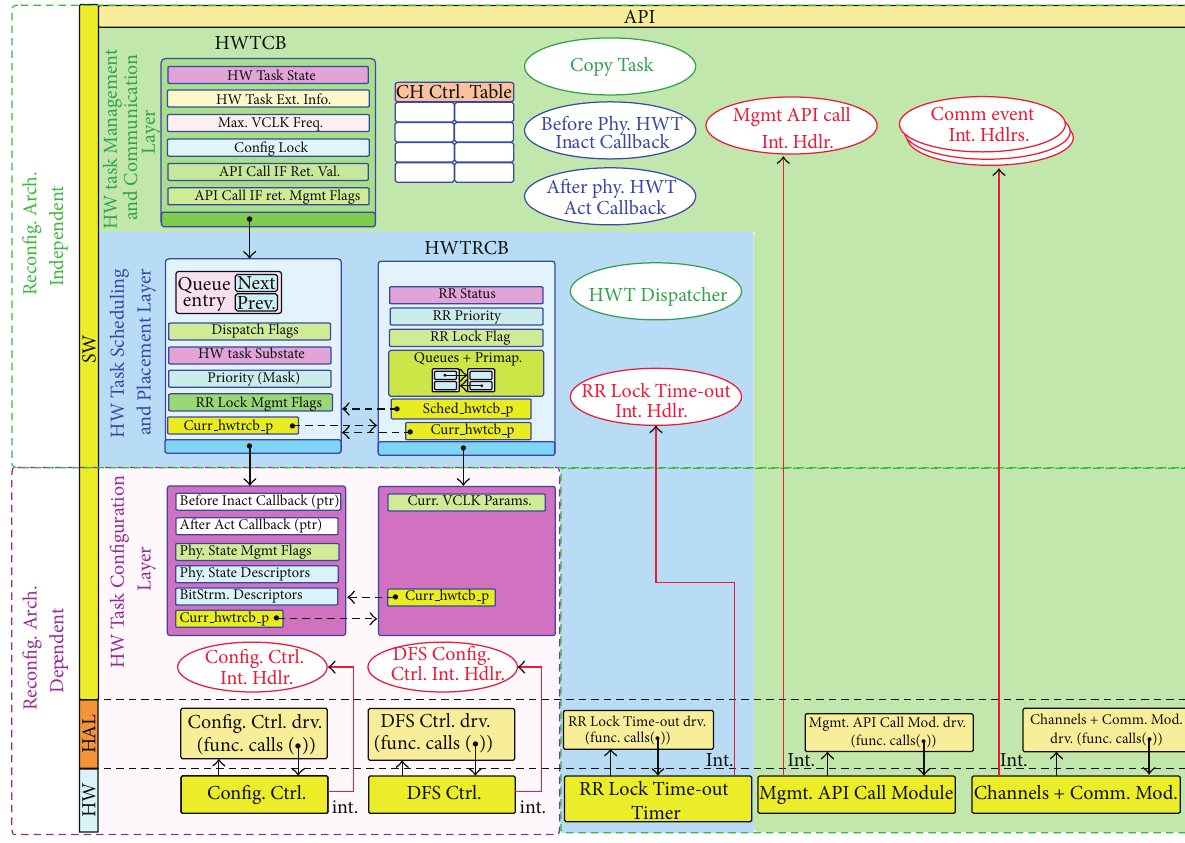
Figure 3: Rainbow extension—software structures and software-hardware